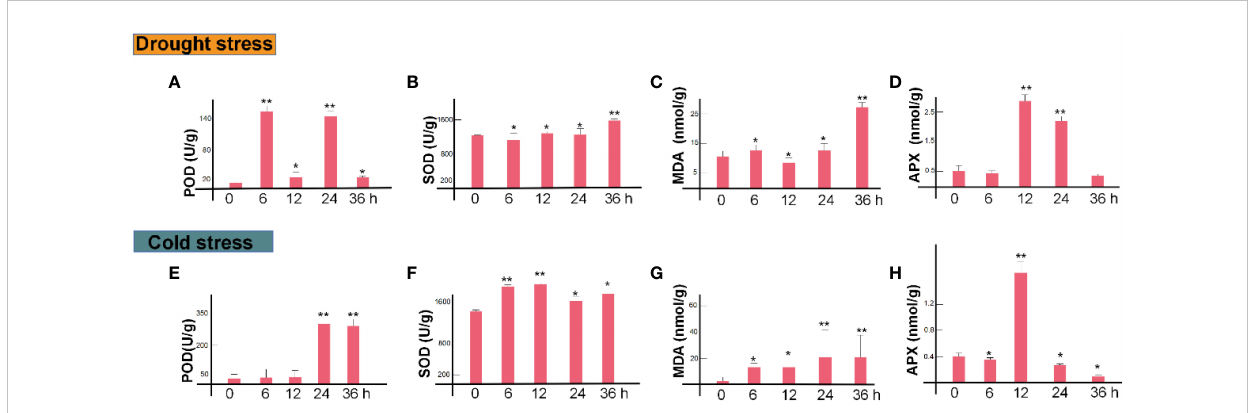
FIGURE 1 Temporal dynamics of M. rubra physiological characteristics during drought and cold treatment. Peroxidase (POD) activity (A) , superoxide dismutase (SOD) activity (B) , MDA (C) and APX content (D) , in M. rubra under drought stress. Peroxidase (POD) activity (E) , superoxide dismutase (SOD) activity (F) , MDA content (G) and APX content (H) , in M. rubra under cold stress. (* P < 0.05, ** P < 0.01, Student ’ s